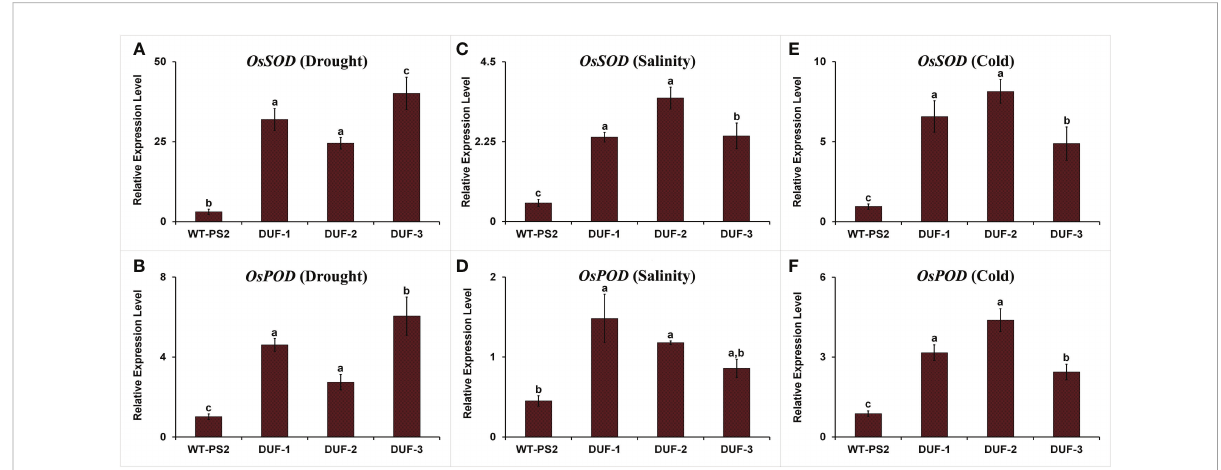
FIGURE 7 Expression level of ROS scavenging genes in WT and AtRd29A::OsSRDP transgenic lines under different abiotic stresses. Quantitative RT-PCR analyses of ROS scavenging genes OsSOD and OsPOD under drought stress (A, B) , salt stress (C, D) , and cold stress (E, F) . Each value represents the mean of relative expression over three biological and three technical replicates, normalized with respect to OsActin as an internal control. Standard error of means (SD/ √ N; N = 9) are used as error bars, and alphabets above the vertical bars represent statistically signi fi cant differences (Duncan ’ s Multiple Range Test: p ≤ 0.05) between transgenic rice lines (AtRd29A::OsSRDP) and WT